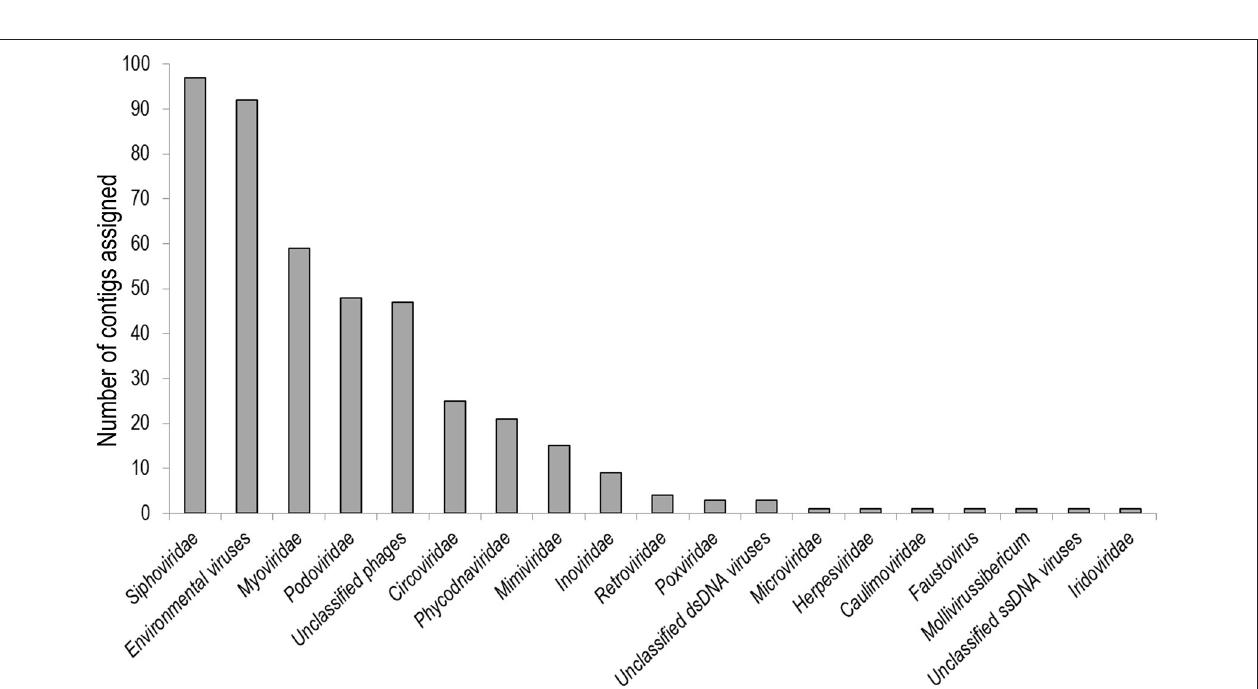
FIGURE 2 | Contigs from the cross-assembly of kelp viromes that were assigned to virus references.